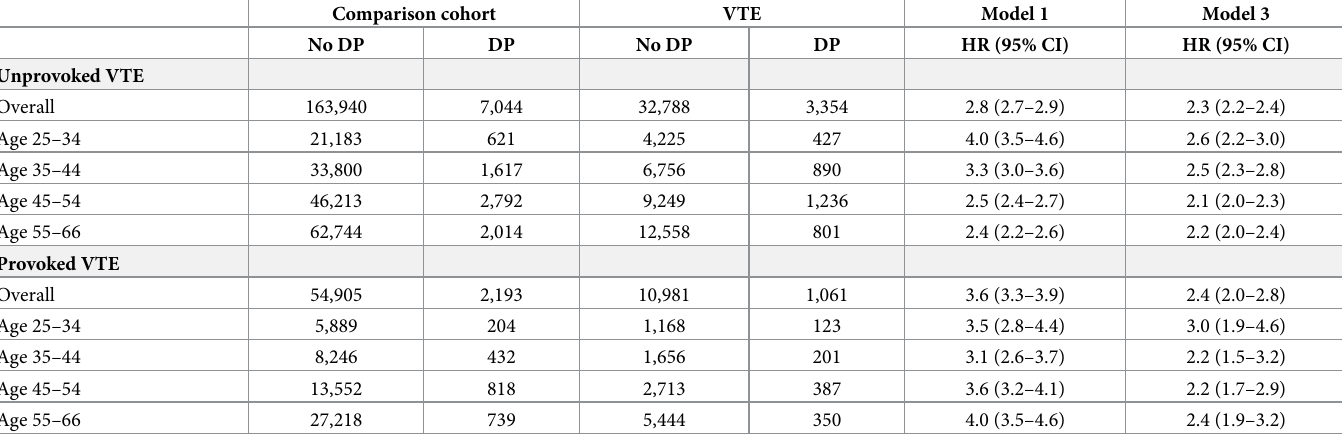
Table 6. Subgroup analysis by age and sex with IRs and HRs with 95% CIs of receipt of a work-related DP among persons with and without VTE by provoked VTE vs. unprovoked VTE.